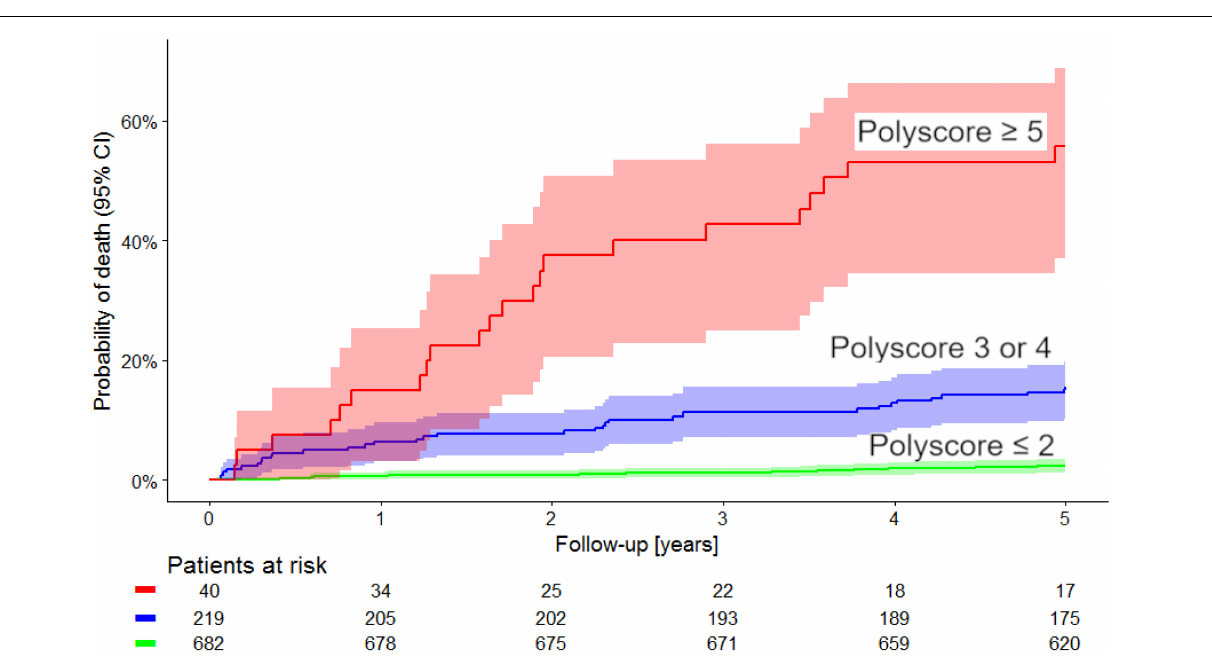
Frontiers in Physiology |